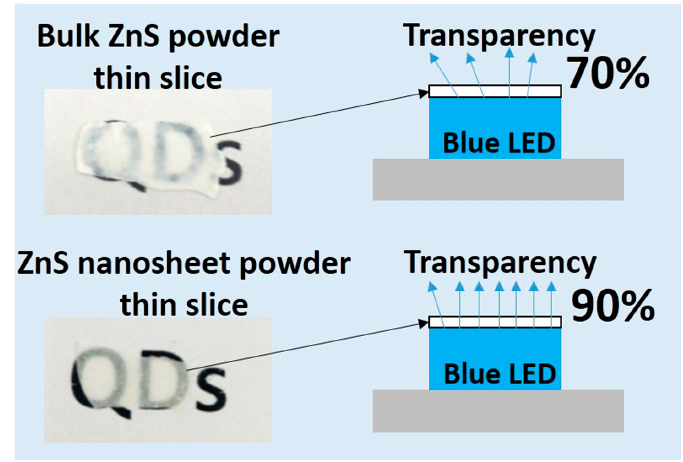
Figure 3. Light transparencies of ZnS nanosheet and bulk ZnS powder thin slices in LEDs.